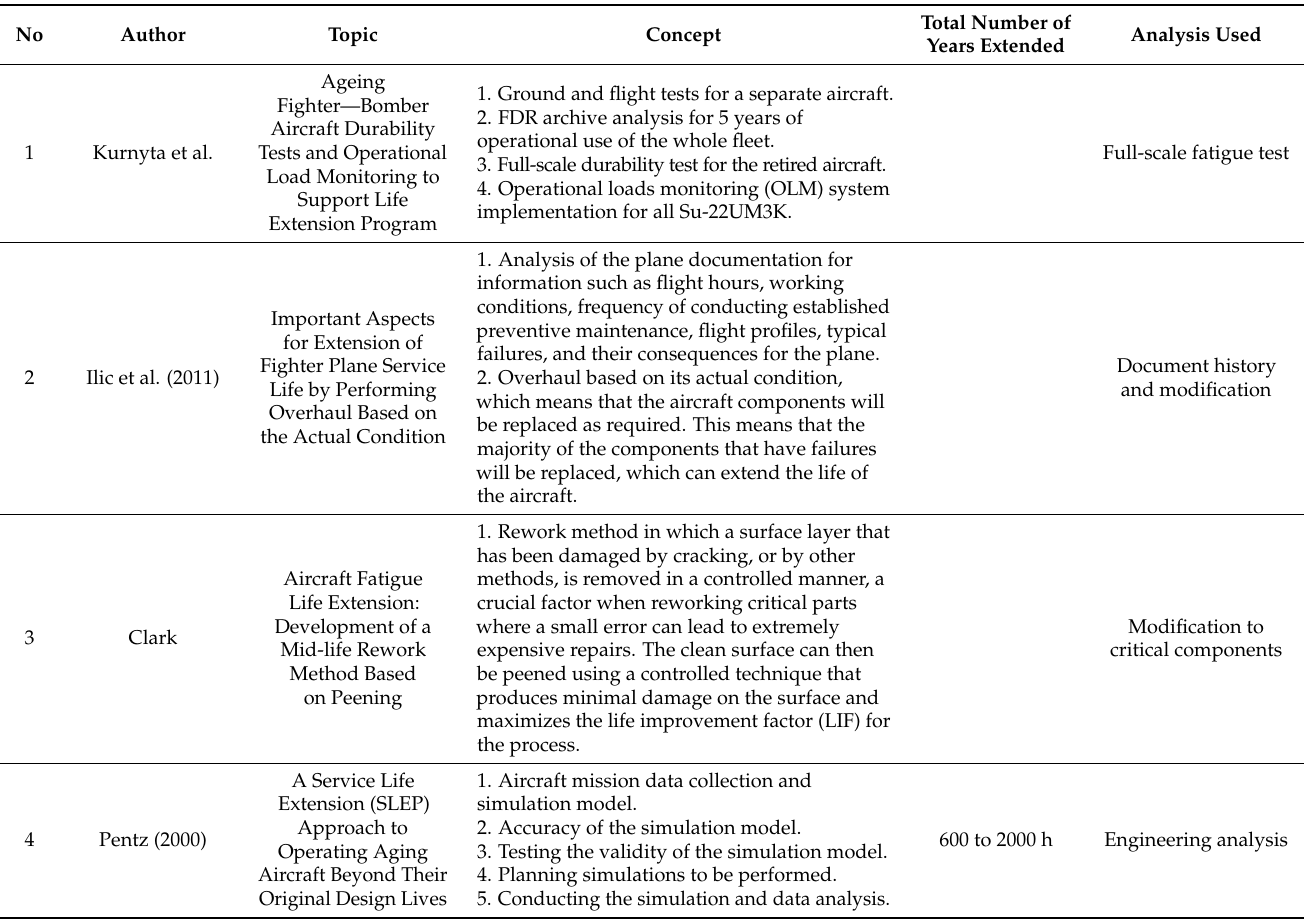
Table 2. Summary of Structure Life Extension